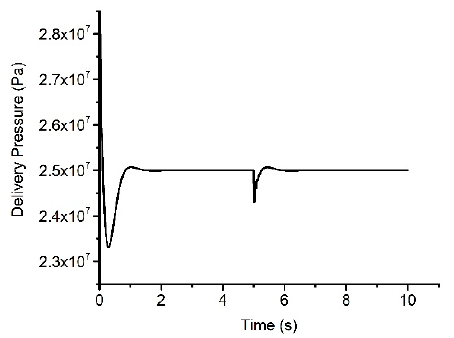
Figure 6. The delivery pressure of EHPAAPP with PID controller in the case of input signal is 25 MPa with flow disturbance at the fifth second.